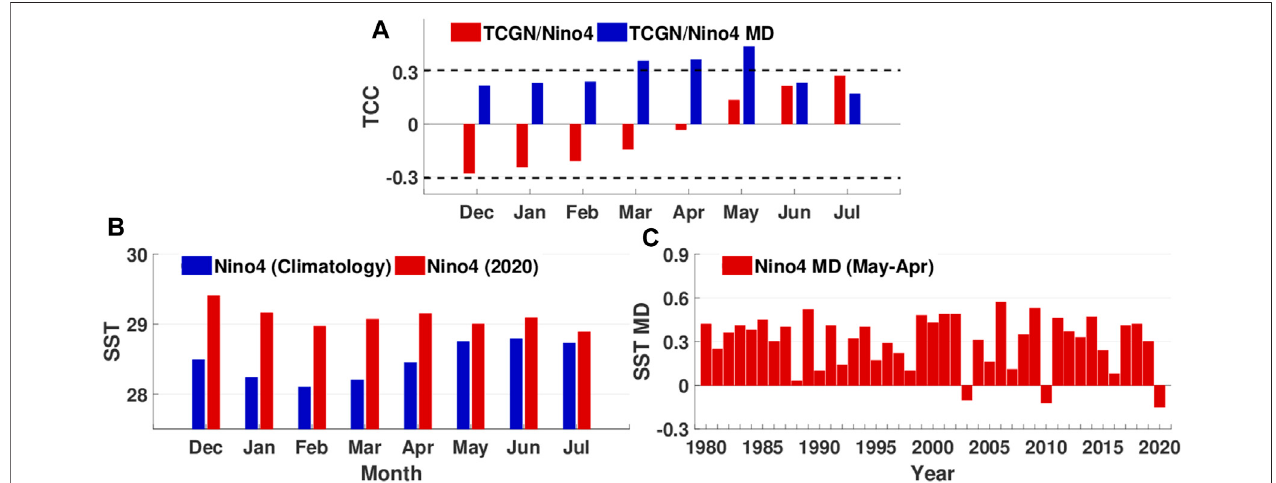
FIGURE 9 | (A) The TCCs between the TCGN in July and the Niño4 index (red bars) , as well as the Niño-4 index MD (blue bars) from December to July during 1980 – 2020. (B) Climatological monthly evolution of SST in the Niño4 region during 1981 – 2020 (blue bars) , and the monthly evolution of the Niño4 index in 2020 (red bars) . (C) Interannualvariability oftheSSTMD between May and Aprilin theNiño4regionduring 1980 – 2020. Units: K.The black lines indicate statisticalsigni fi cance at the 95% con fi dence level, as estimated by a Student ’ s t